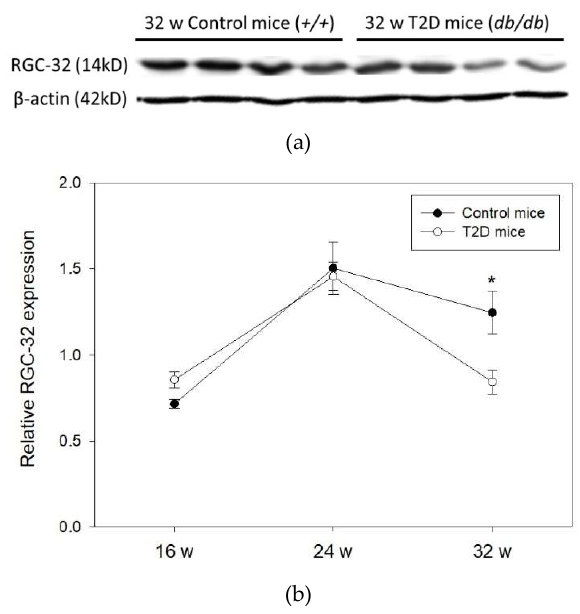
Figure 3. ( a ) Representative western blot image of RGC-32 expression in T2D and control mouse retina ( b ) RGC-32 expression relative to that of β-actin in mouse retina at 16, 24, and 32 weeks (w) of age. Data are presented as mean ± SD. * p = 0.030 ( t -test).